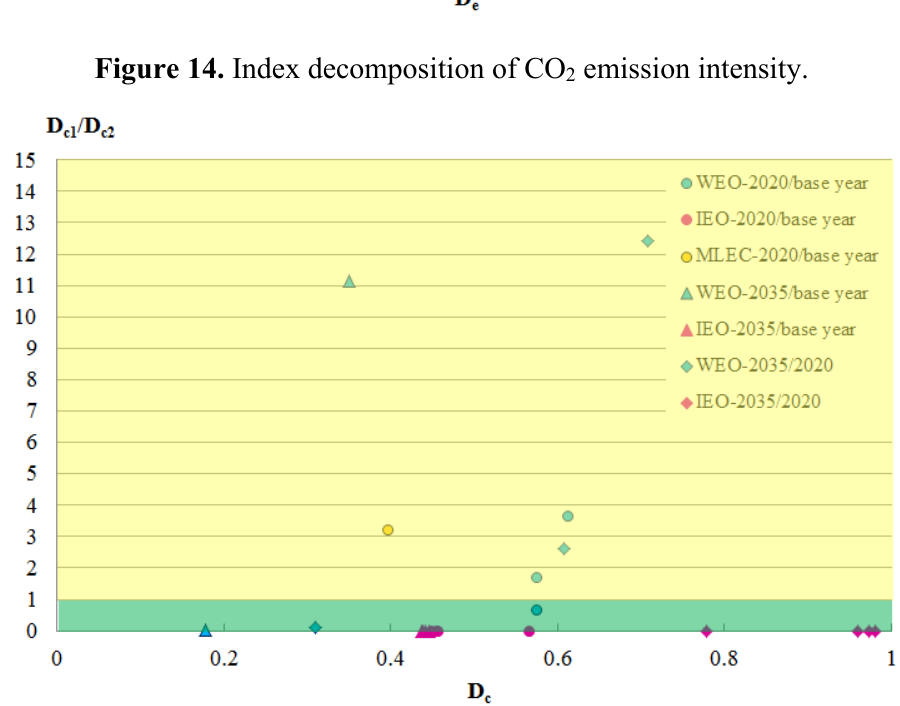
Figure 14. Index decomposition of CO